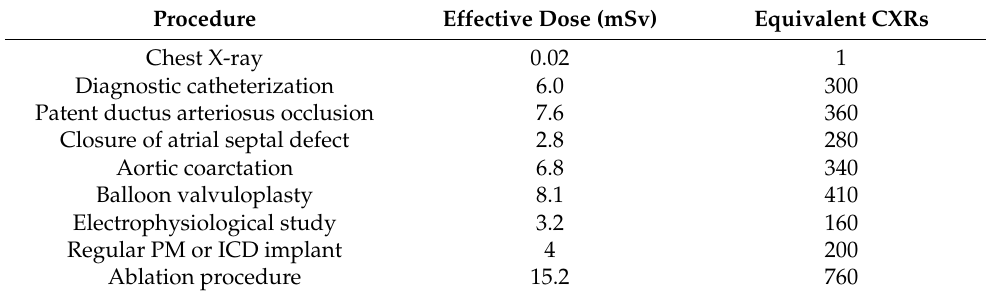
Table 2. Average radiation dose for common ionizing procedures in CHD patients. Procedure Effective Dose (mSv) Equivalent